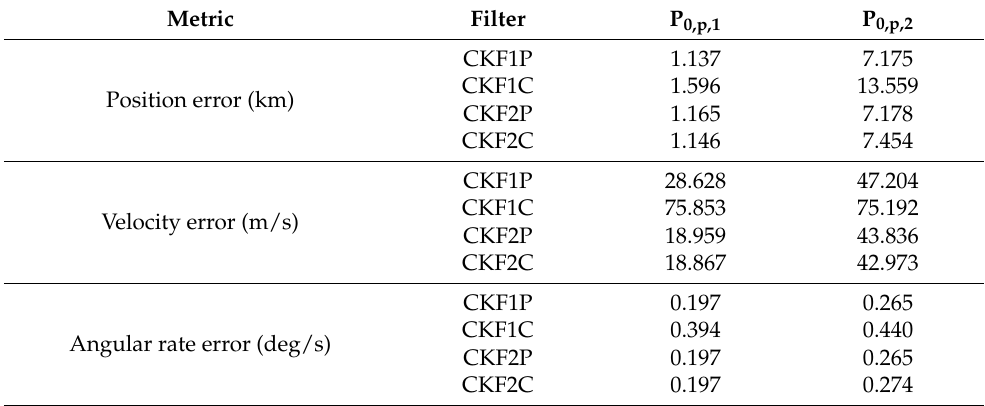
Table 6. Comparison of RTAMS position, velocity, and angular rate errors for CKF1P, CKF1C,